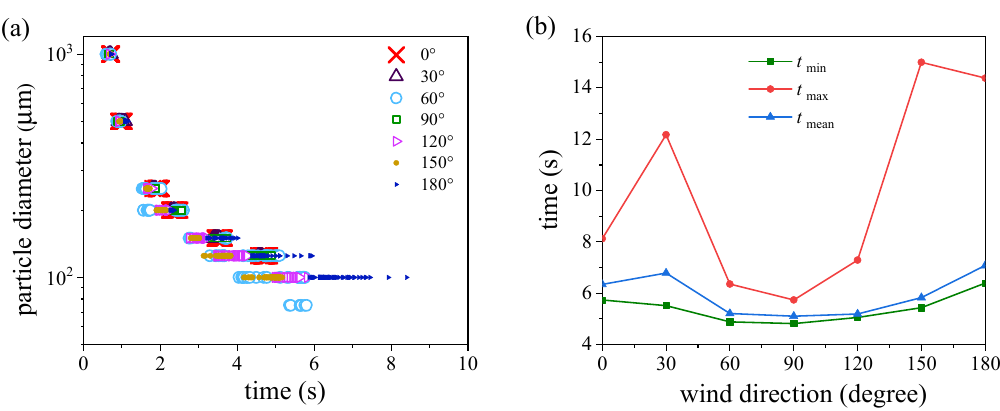
Figure 14. Ground deposition times and domain escape times: ( a ) ground deposition time of droplets of various sizes in different wind directions; ( b ) the maximum, minimum, and average escape times in different wind fields.